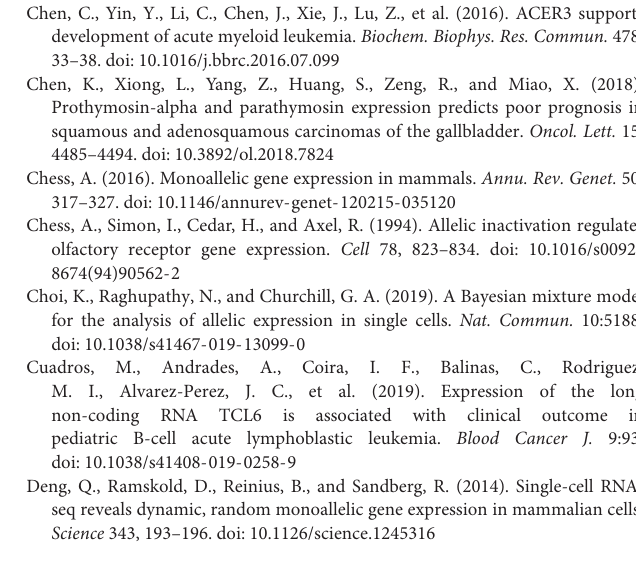
Supplementary Figure 1 | Q-Q plot of VAF of in BMMCs, estimated by UMI counts. Supplementary Figure 2 | tSNE projection of BMMCs (background), colored by the expressed allele of IL32 (A) , HLA-DRB5 (B) , and NUP210 (C) . The size of the highlighted dot is scaled to log 10 of its UMI count, and the pie chart in the bottom right shows the genetic allelic ratio of the two alleles from WGS data. Supplementary Figure 3 | Identification of constitutive MAEs in diagnosis (A) , refractory (B) , and relapse (C) , with blue representing MAE of the reference allele while red representing MAE of the alternative allele. The percentage of the SNVs with constitutive MAE is shown on the top left of the plot. Supplementary Figure 4 | tSNE projection of all BMMCs from the boy diagnosed with leukemia, colored by sampling times, namely control, diagnosis, refractory, and